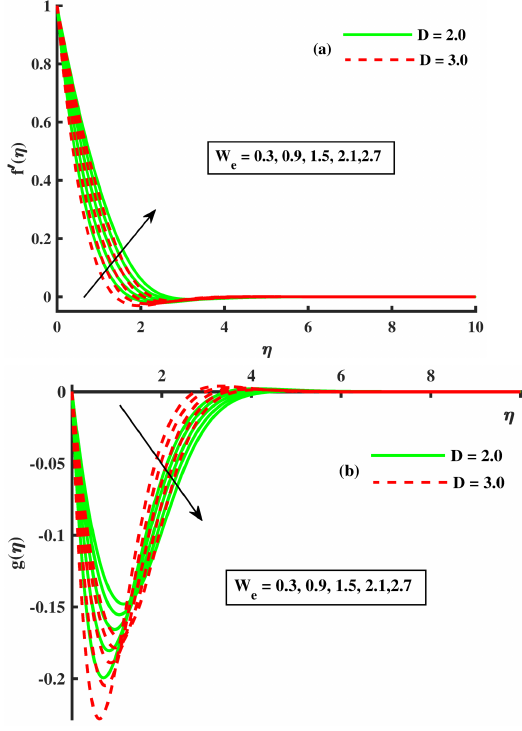
Figure 4. The effect of W e & D on f (cid:48) ( η ) & g ( η ).